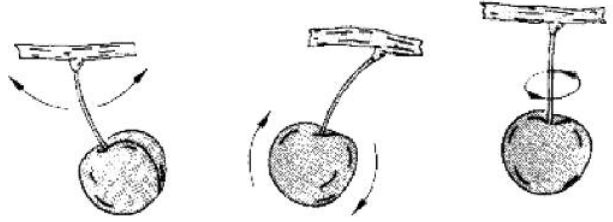
Figure 6. The three important modes of oscillation of the fruit ( Cooke & Rand